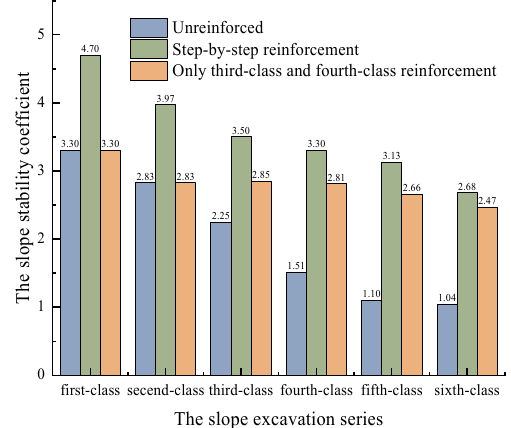
Figure 11. Comparison of slope reinforcement schemes.